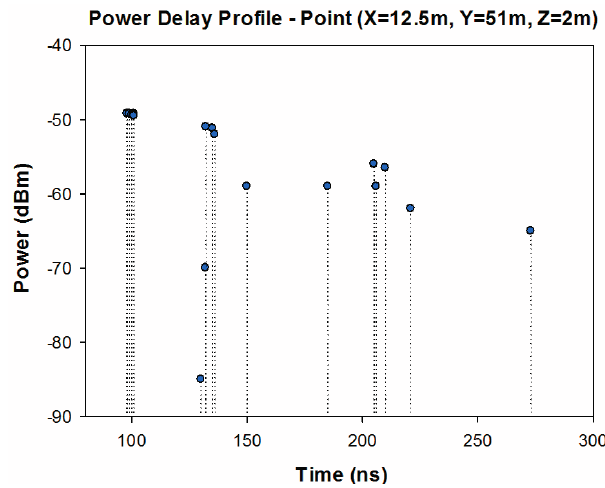
Figure 7. Power Delay Profile at a given cuboid, located at the central location in the considered scenario.